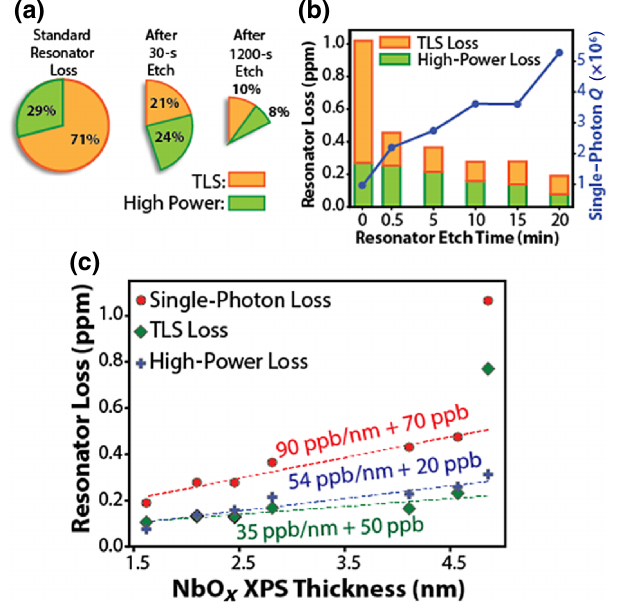
FIG. 7. (a) Pie plots comparing the loss distributions before and after etching. TLS losses dominate standard resonators, while non-TLS losses become more important with etching. The shortest etch reduces the total loss by half, while a 1200-s etch reduces the loss more than fivefold. (b) The resonator loss com- ponents and the quality factor as a function of the etch time (note the nonlinear x axis). (c) Linear fits to loss components versus the NbO x thickness. The δ TLS : δ hi loss-density ratio is 3:4. The residual δ TLS and δ hi losses extrapolated to zero thickness are 50 and 20 ppb, respectively, compared to starting values of 770 and 310 ppb.